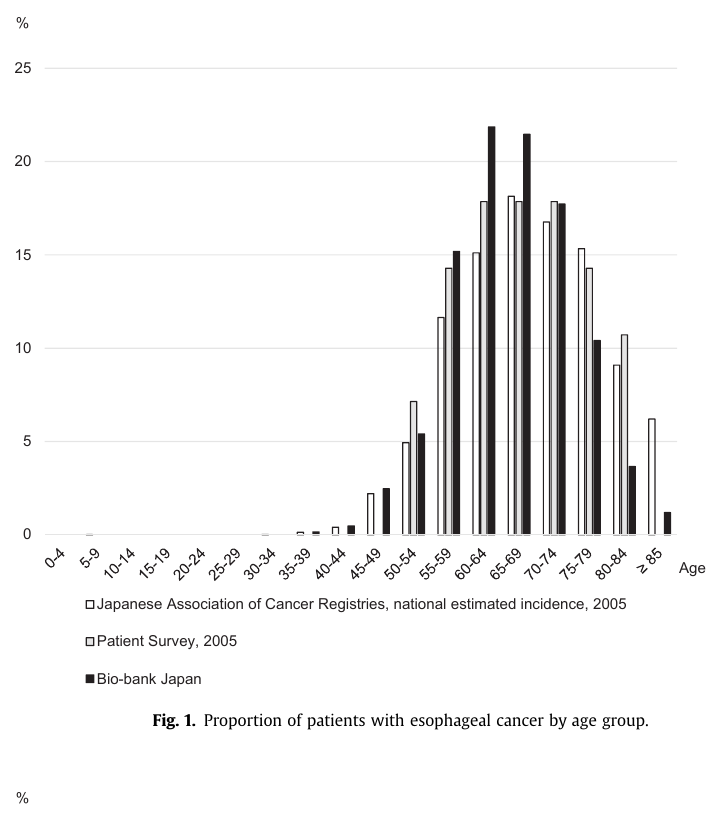
Fig. 1. Proportion of patients with esophageal cancer by age group.